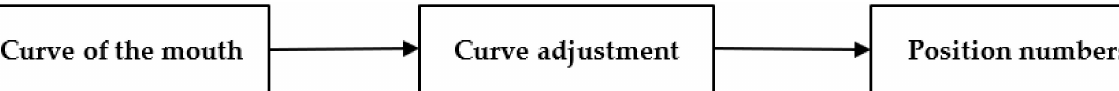
Figure 9. Cutting flow chart.